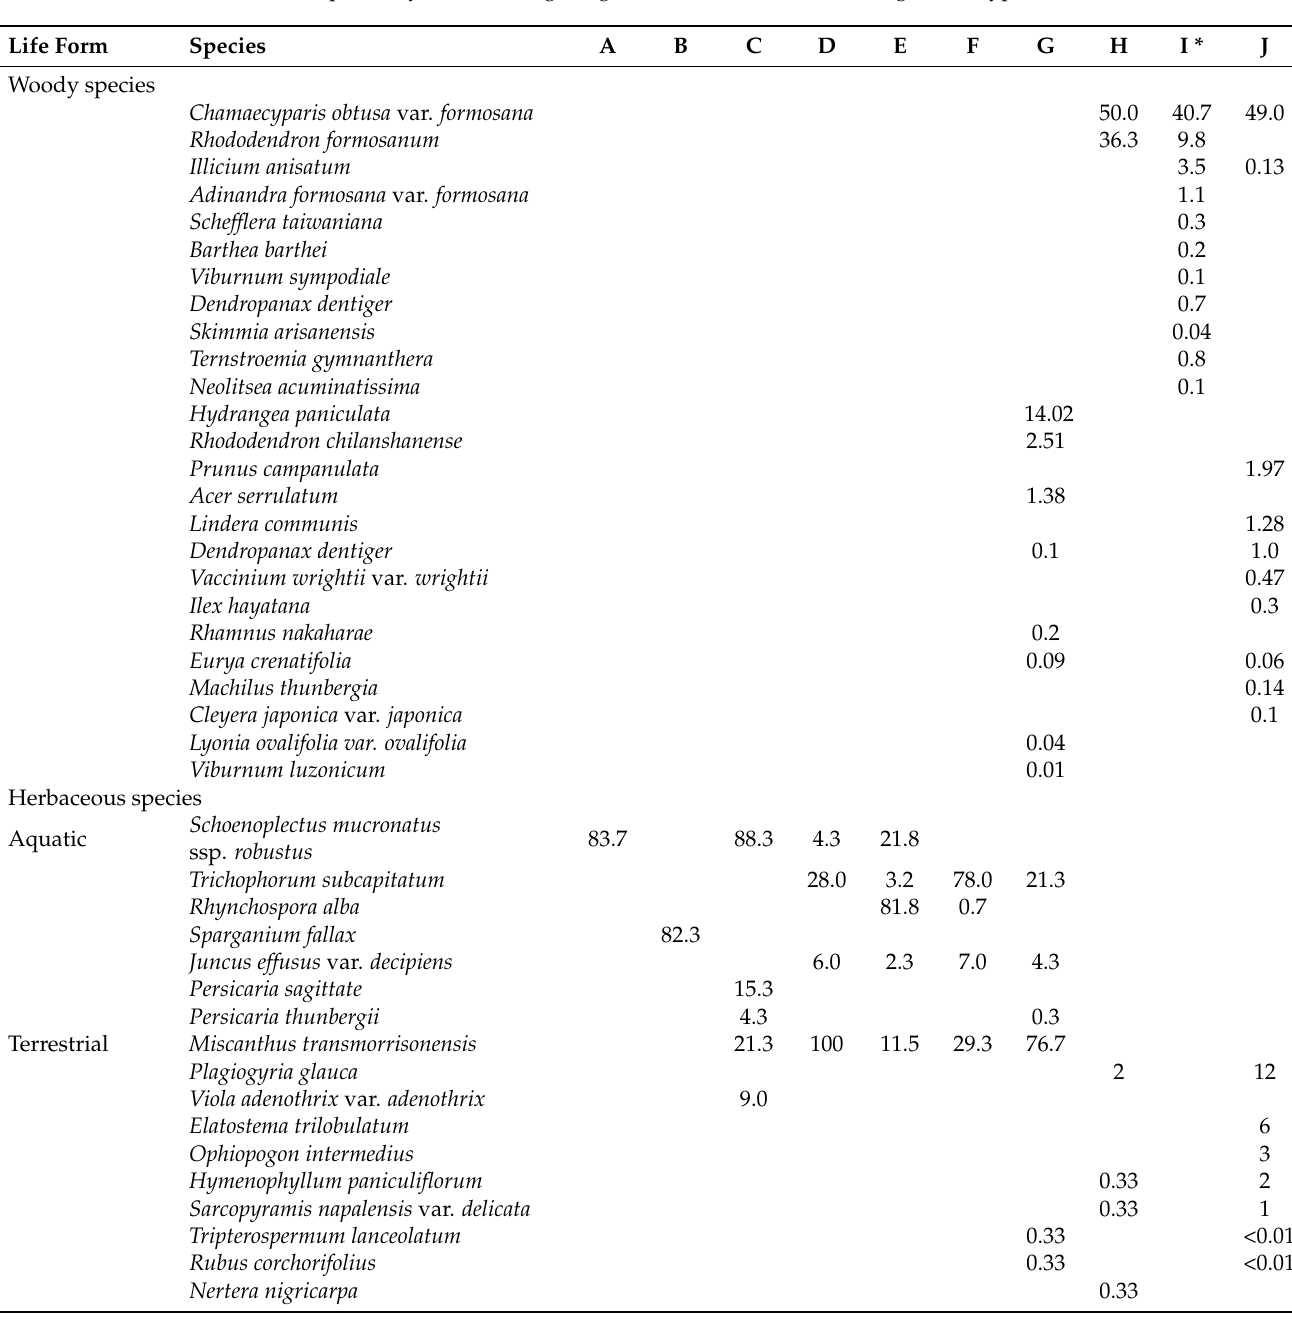
Table 2. Dominant plant species in the 10 vegetation types in this study. Dominance of the woody species was determined on the basis of the basal area of the ground area (m 2 ha − 1 ) and the herbaceous species by their coverage of ground area (%). * Data for vegetation type I were cited from